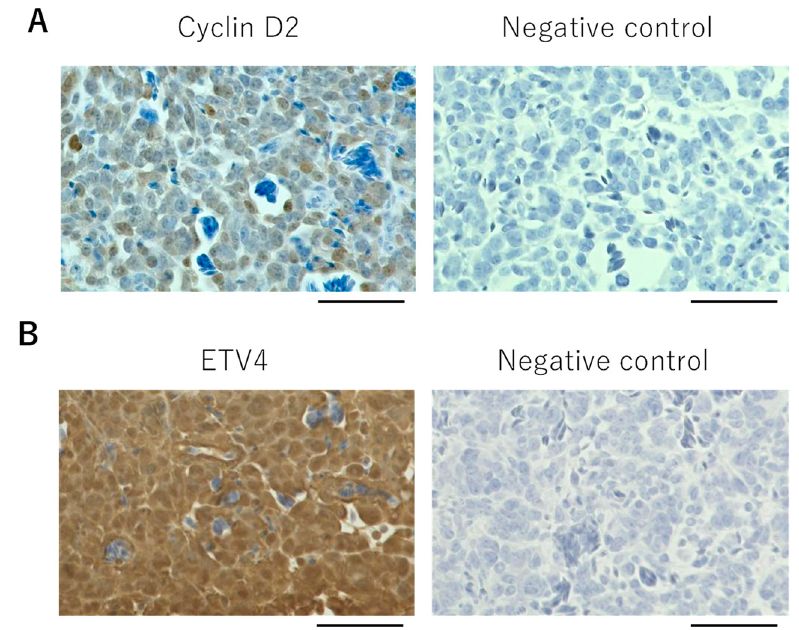
Figure 3 . Immunohistochemistry of CD-292 CAM tumor. Stained with cyclin D2 antibody ( A ) or with ETV4 antibody ( B ). Negative controls are staining without antibody. Scale bar represents 0.05 mm.